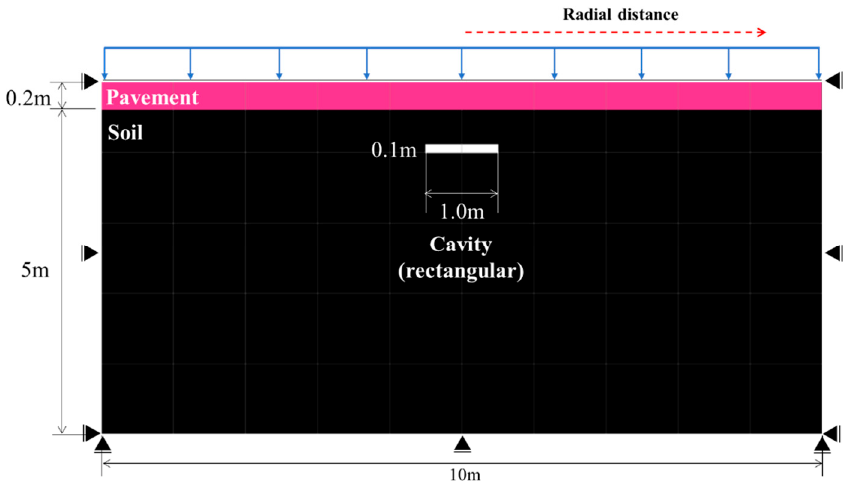
Figure 3. Numerical analysis model.